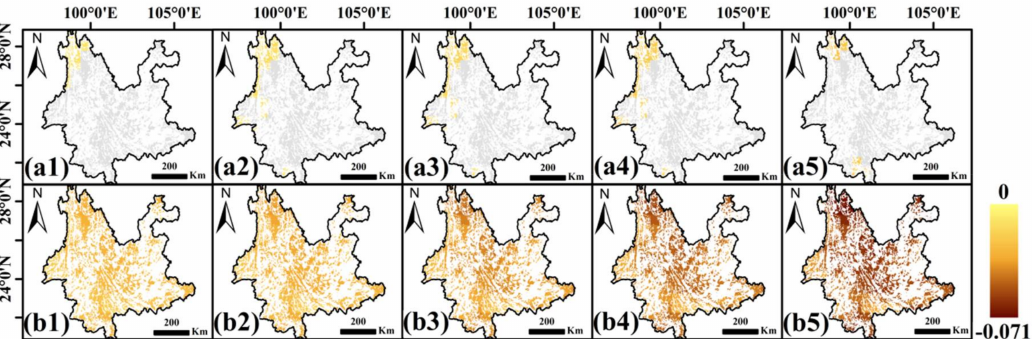
Figure 8. Pattern of spatial variation in the coefficient of the temporal variation trend of dEVI future following global climate change. ( a1 – a5 ) show the coefficients of <30, 30–60, 60–90,